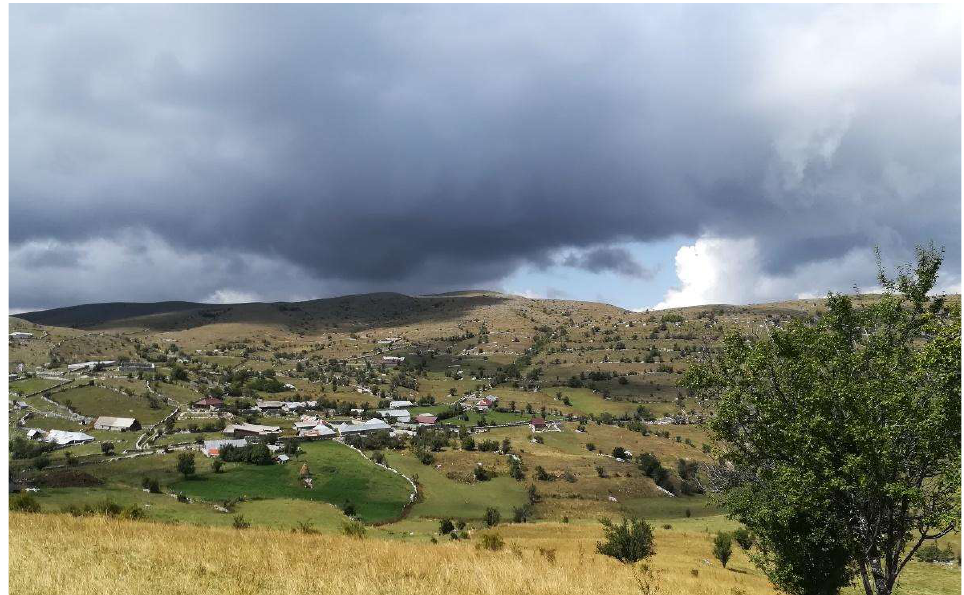
Figure 3. The ancient shepherding- and rye-driven settlement of Gurguricë, before locals relocated one century ago to the new village, approximately 1 km eastwards (Photo: A. Pieroni).